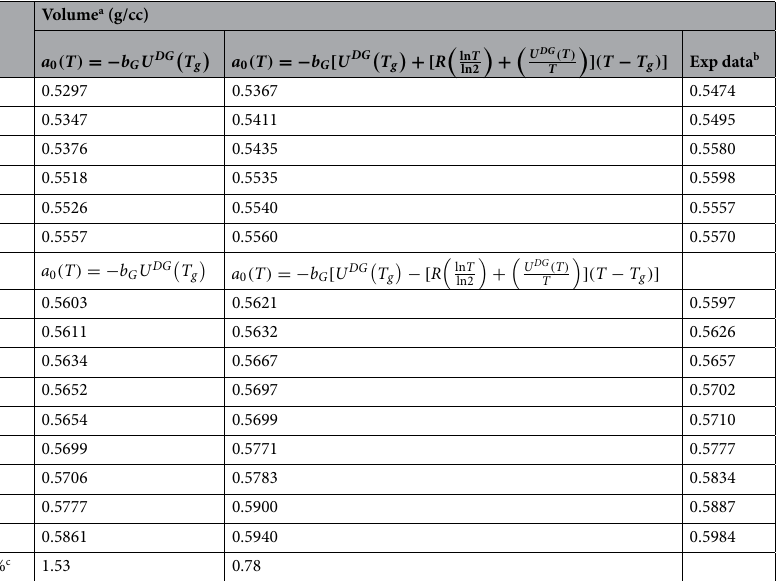
Table 3. Volumes of B 2 O 3 glass calculated with and without soft repulsion effects in a 0 ( T ) . a T g = 535.27 K; b G = 35.752 cm 3 /mol; U D